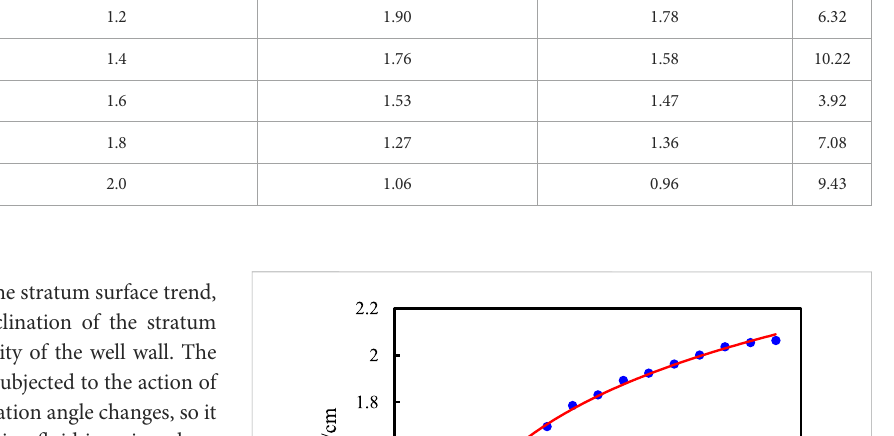
TABLE 6 Calculated and experimental values of invasion depth under different viscosities of the drilling fl uid. Invasion pressure/MPa